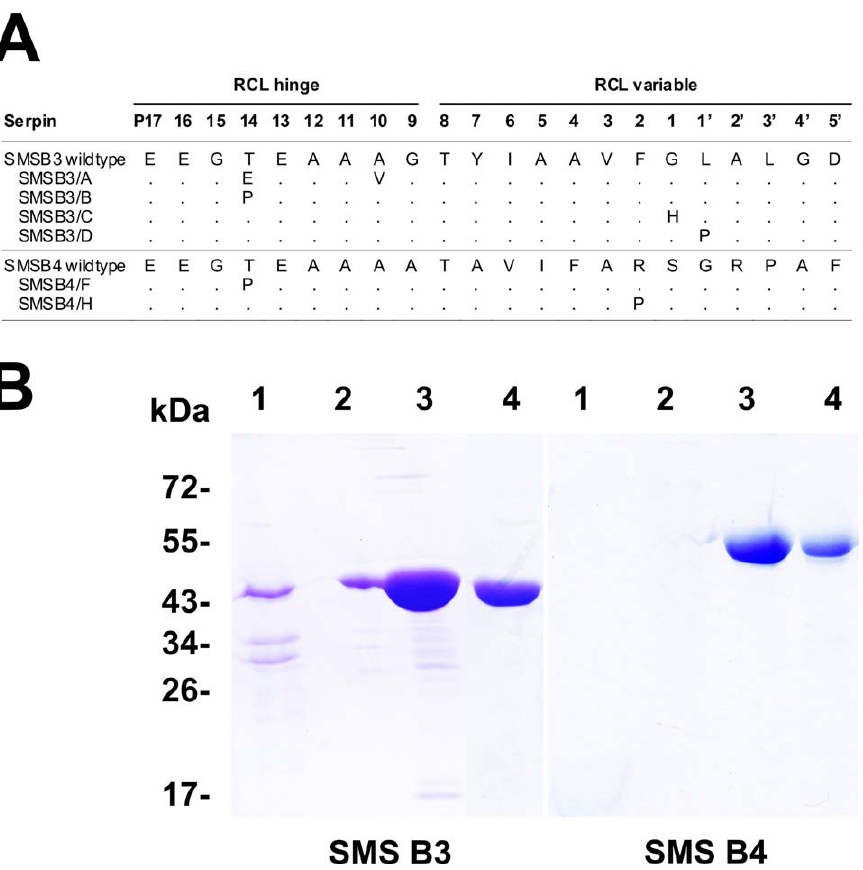
Figure 1. Sequence details and recombinant expression of SMSs and mutants. (A) Shown are the sequence changes in the SMS mutants compared to wild type sequences. Numbering scheme according to [82]. Point mutations were introduced in the two segments of the RCL domain: i) the distal (P9-P5’) variable region that resembles the protease substrate and is attacked by a target protease, and ii) the proximal (P15-P9) hinge region that is well conserved and inserts into b -sheet A during inactivation of a protease in inhibitory serpins. (B) Purification and refolding of SMSB3 and SMSB4. Shown are immobilized nickel affinity chromatography fractions after separation by SDS-PAGE and Coomassie staining. Both SMSs revealed the expected bands of 47 kDa and 54 kDa, respectively. 1, loaded sample; 2, wash; 3, elution with 250 mM imidazole, 4, active serpin after refolding.